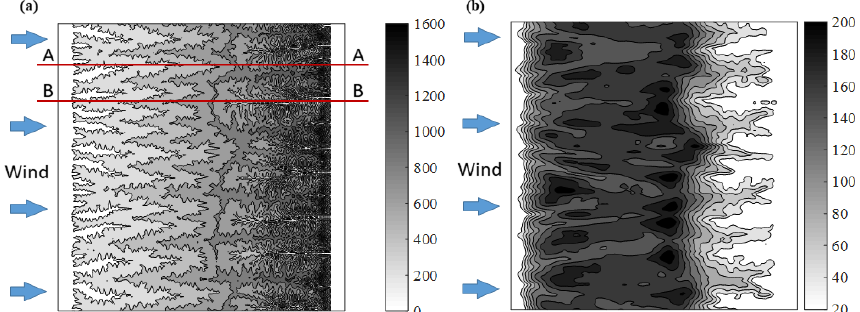
Figure 6. Contour map of simulated (a) surface topography and (b) rainfall field from the co-evolution simulation with V = 16ms − 1 and t d = 1200s after 5Ma (its transect shown in Fig. 3b). Numbers in the legend indicate the surface elevation (m) and rainfall excess rate (mmd − 1 ), respectively.